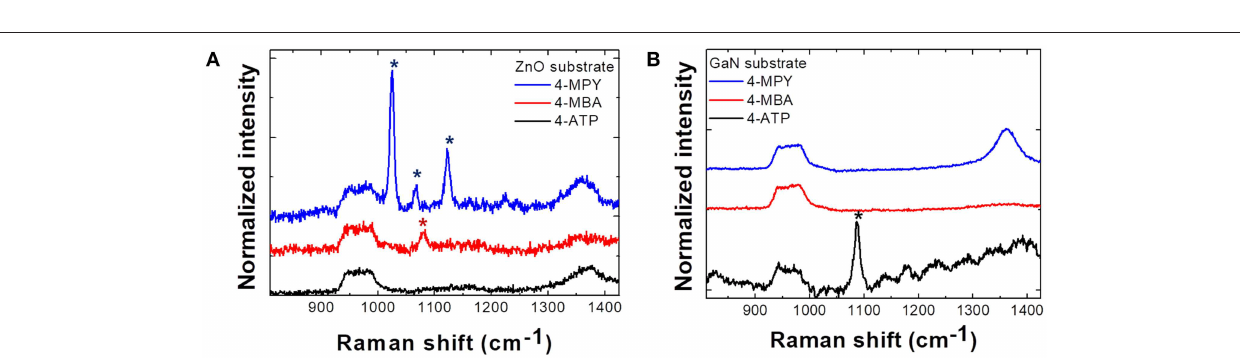
Frontiers in Chemistry |